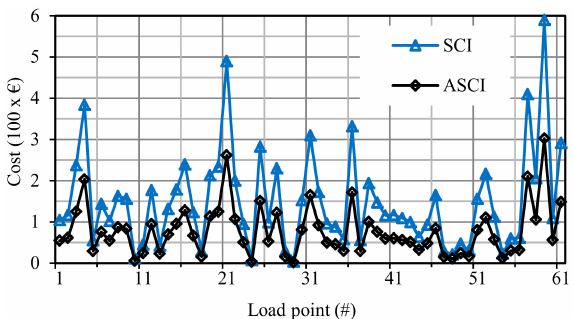
Figure 11. SCI and ASCI associated with di ff erent load points in the network.